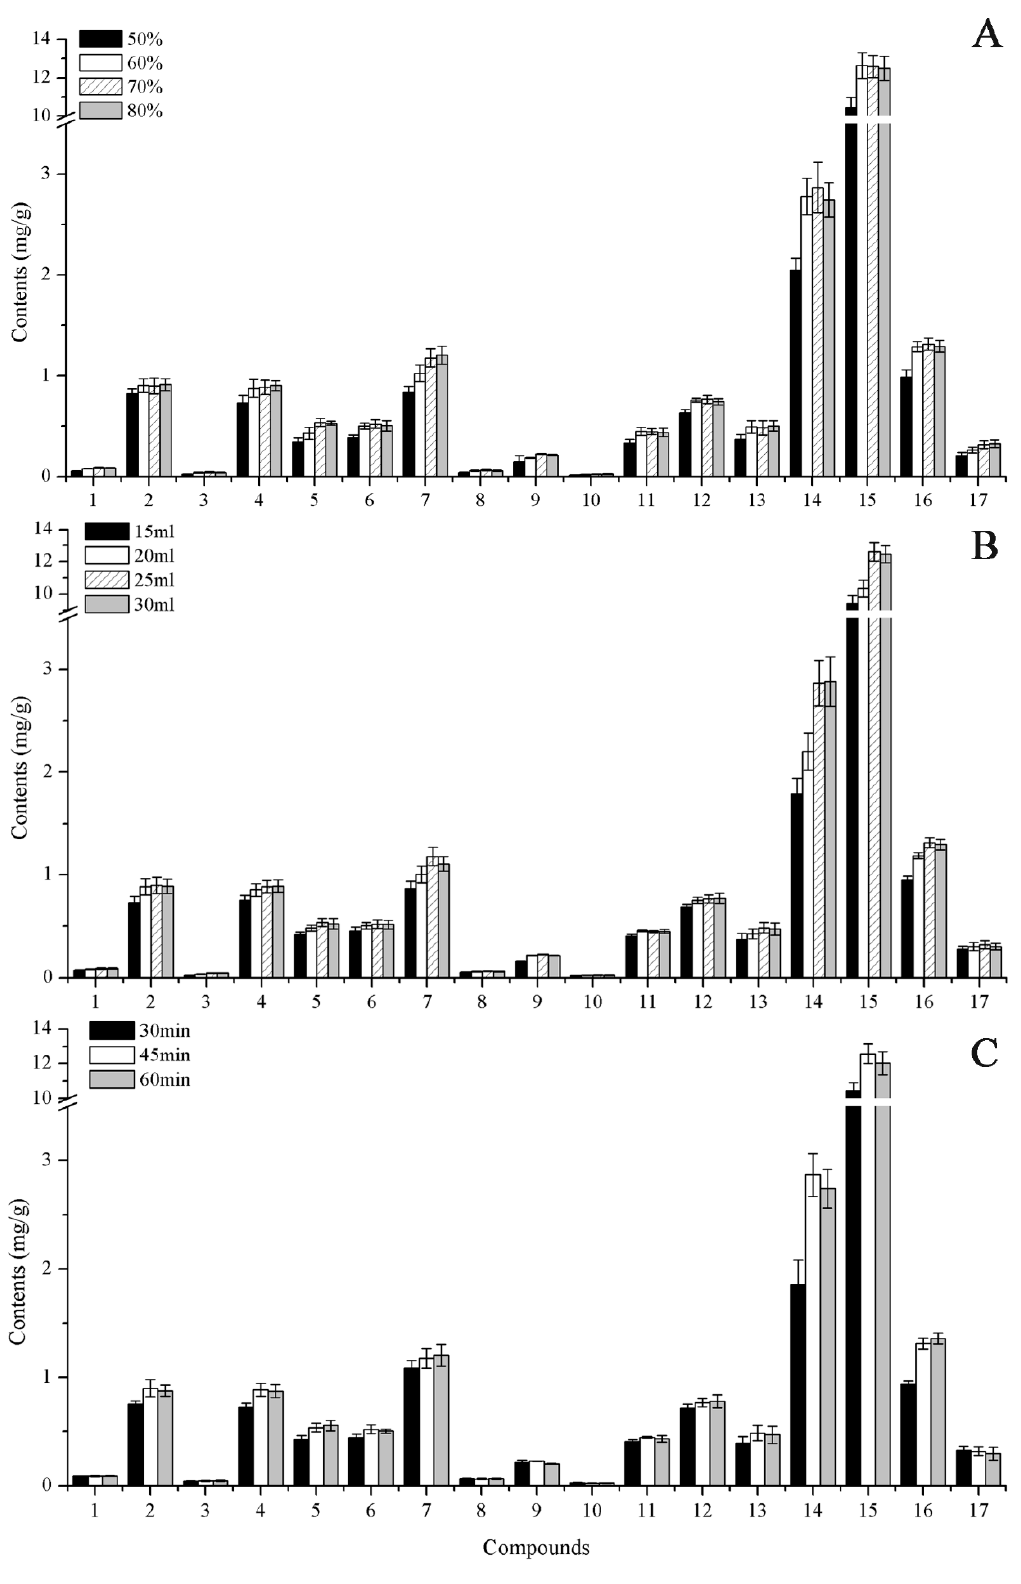
Figure 3. Effects of ( A ) solvent concentration, ( B ) solvent volume, and ( C ) extraction time on the extraction efficiency of target analytes in S9 sample.